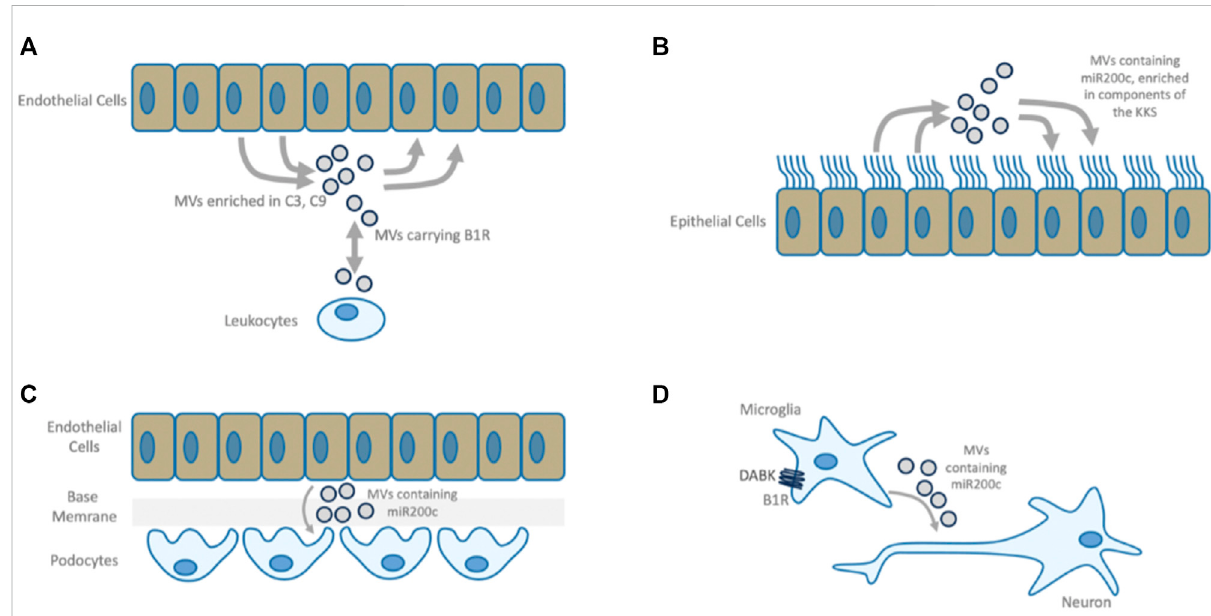
FIGURE 7 B1R mediated MVs. (A) B1R bearing microvesicles (MVs) participate in bi-directional communication between leukocytes and endothelium. PlasmafromvasculitispatientsisenrichedinC3-andC9-positiveendothelialMVswhichcanbereversedbyB1R-antagonismorbysupplementation of SERPING1 (Lopatko Fagerström et al., 2019). (B) MV-based intercellular communication between airway epithelial cells. Airway epithelial cell secretionsareenrichedwithcomponentsoftheCASandKKSandcontainbothpositiveandnegativeregulatorsofthesesystems,indicatingthat under normal conditions this mechanism constitutes a well-balanced communication system. This is in line with the observation that pulmonary epithelial cells express active peptidases along their surfaces to degrade kinins rapidly, keeping the system in balance and protecting the lung from edema (Ghebrehiwet et al., 2019). These MVs also carry miR200c. (C) In Kidney Disease, activated endothelial cells cause functional changes to podocytes via MV transfer, causing endothelial barrier breakdown. miR200c bearing MVs are transferred in response to in fl ammatory mediators and inducemitochondrialstress,decrease VEGFsecretion andincrease expression ofmiR200c intarget cellsleadingto podocyte dysfunction (Hill etal., 2020).Antagomirtreatmentamelioratesthisdiseasephenotype(Ottavianietal.,2019).Endothelialcellactivationbythesamein fl ammatorymediator inducesepithelialbarrierdamage,nephrotic-rangeproteinuria,renalepithelialcelldamage,in fi ltrationofmononuclearleukocytes,andapoptosisof several renal cell types (Moreno-Manzano et al., 2003), a phenotype that is similar to B1R activation. (D) miR200c bearing MVs transferred from microglia to neural cells upon B1R activation mediate neuronal damage. B1R antagonism improves the neurologic function and causes downregulation of both miR200c in microglial cells and the quantity of MVs released microglial cells. MVs from miR200c knockdown cells have the same effect on neuronal cells as MVs derived from cells treated with B1R antagonist (Tang et al.,